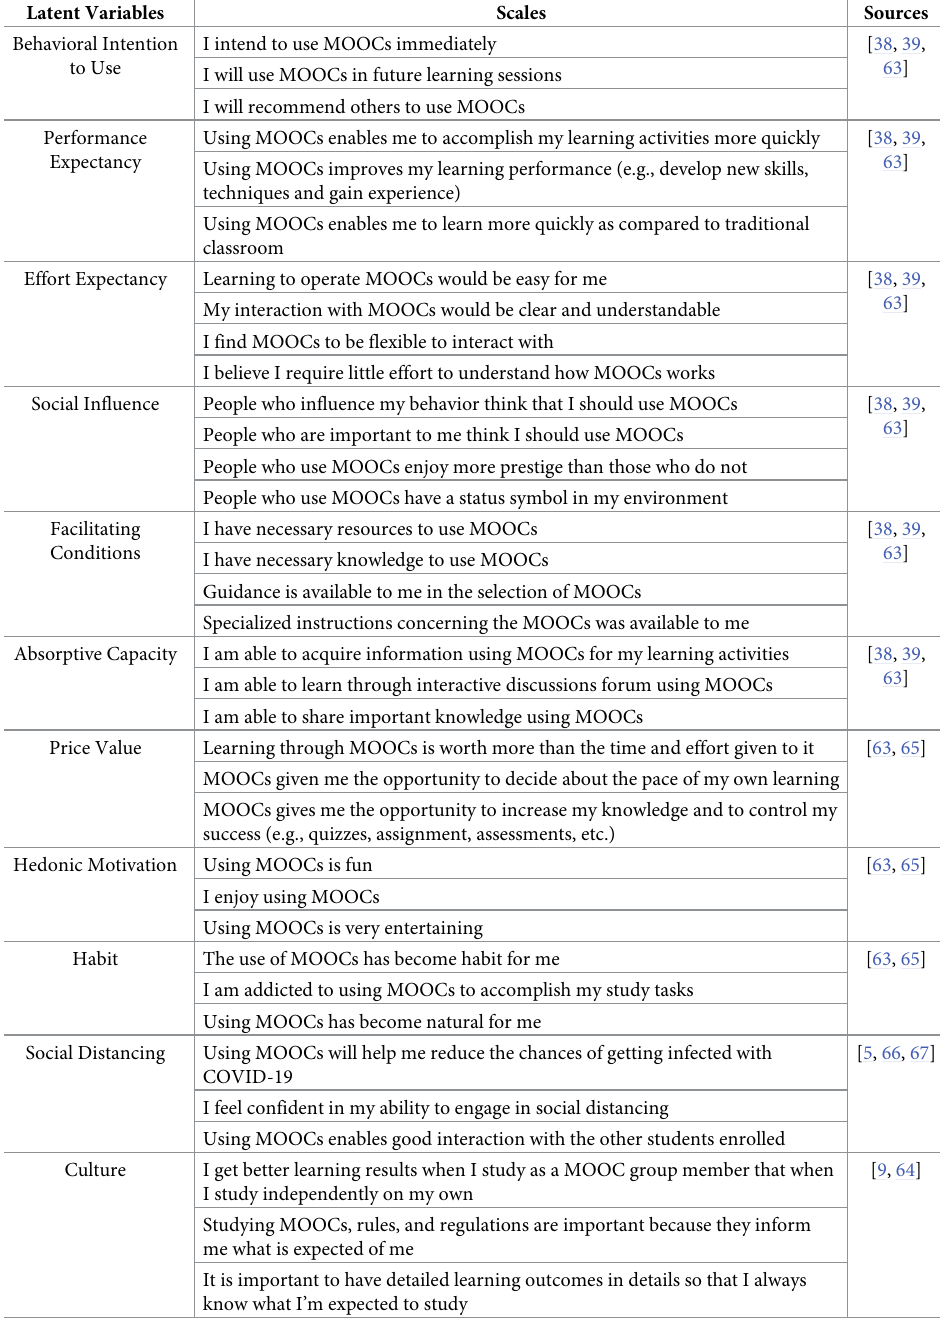
Table 1. Measurement